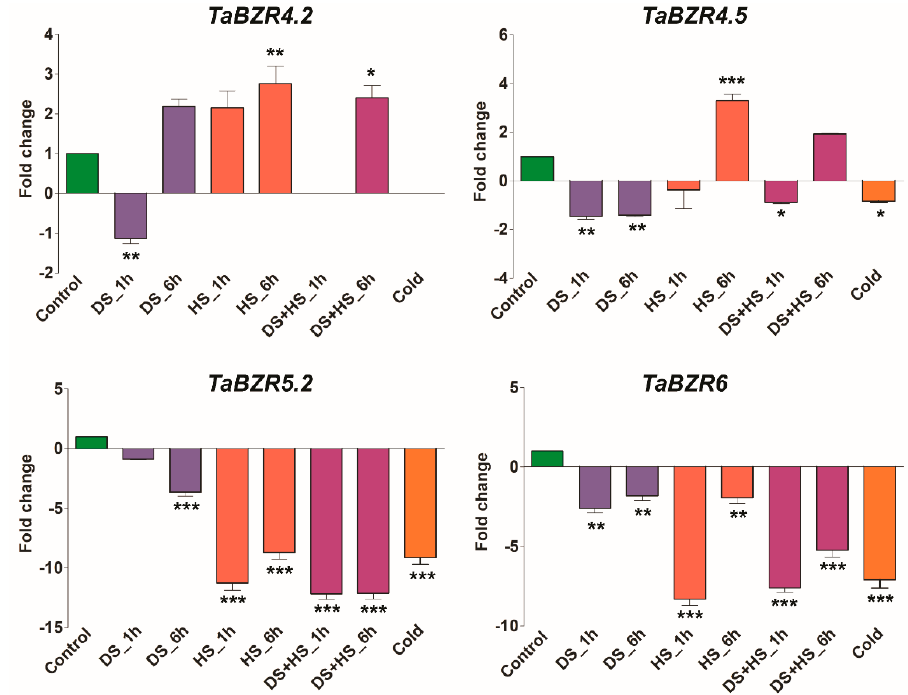
Figure 9. Quantitative real-time PCR analysis of selected TaBZR genes in response to drought, heat, and cold stress to verify RNA-seq data. The wheat actin gene was used as Table S9 and <0.001 level (* p < 0.05, ** p lies in between the values of 0.05 and 0.001, and *** p < 0.001). Error bars show standard deviation. Data are mean ± SD ( n = 3).